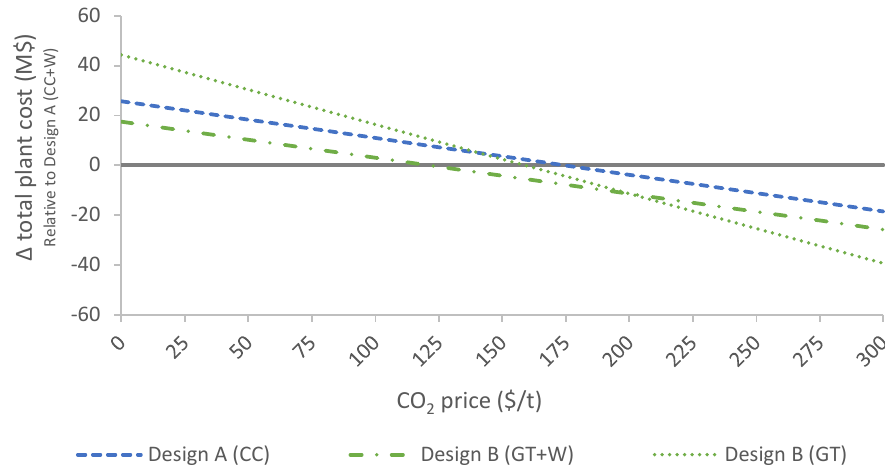
Figure 14. Variation of the total plant cost of Design A (CC), Design B (GT+W) and Design B (GT) relative to Design A (CC+W), as a function of the CO 2 price.